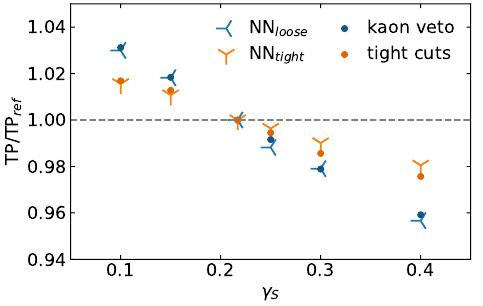
Figure 9 . Sensitivity of the number of TP events to the s ¯ s -popping probability γ s . The number of TP events at the P YTHIA8 default is chosen as a reference value for each of the considered ML and cut-and-count approaches, TP = TP ( γ = 0 . 217) . The tight cuts are defined by the cuts listed in ref s eq. (3.6) plus M 1 . 5 X <